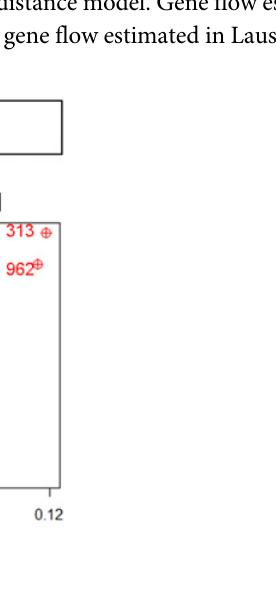
Fig 7. Results of the Bayesian outlier search under a 10% expected